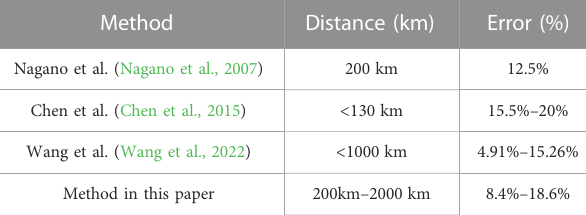
TABLE 2 Comparison between existing methods and methods in this way on single-site lightning